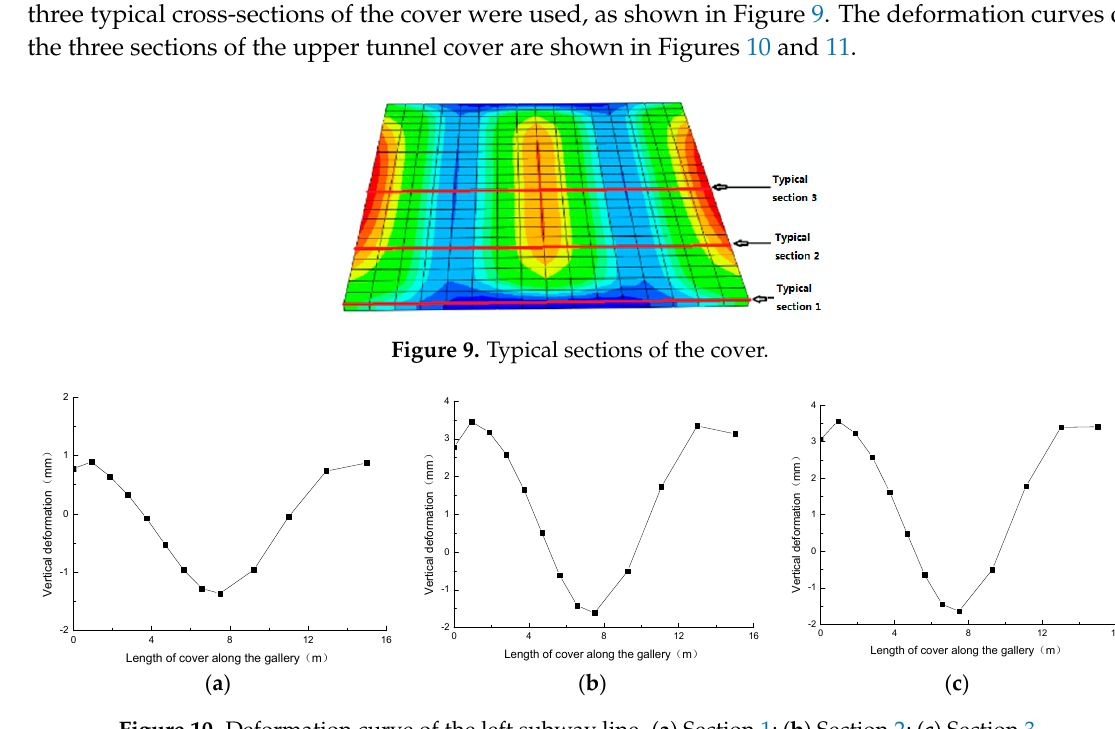
Figure 10. Deformation curve of the left subway line. ( a ) Section 1; ( b ) Section 2; ( c ) Section 3.